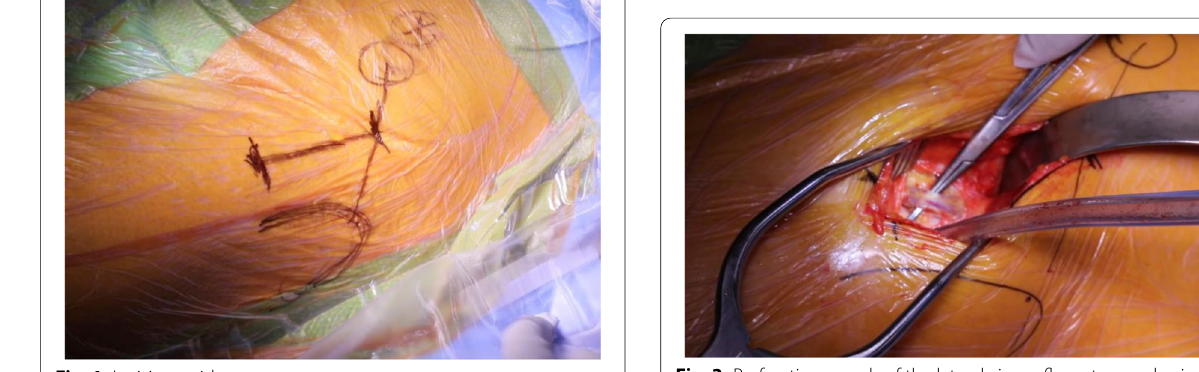
Fig. 3 Perforating vessels of the lateral circumflex artery and